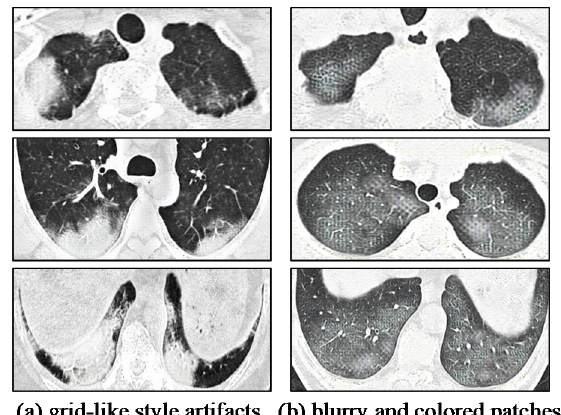
Figure 14. ( a,b ) Examples of style-artifacts manifested on synthetic COVID-19 CT images. These Figure 14. ( a , b ) Examples of style‑artifacts manifested on synthetic COVID‑19 CT images. These samples are generated from other GAN baselines. samples are generated from other GAN